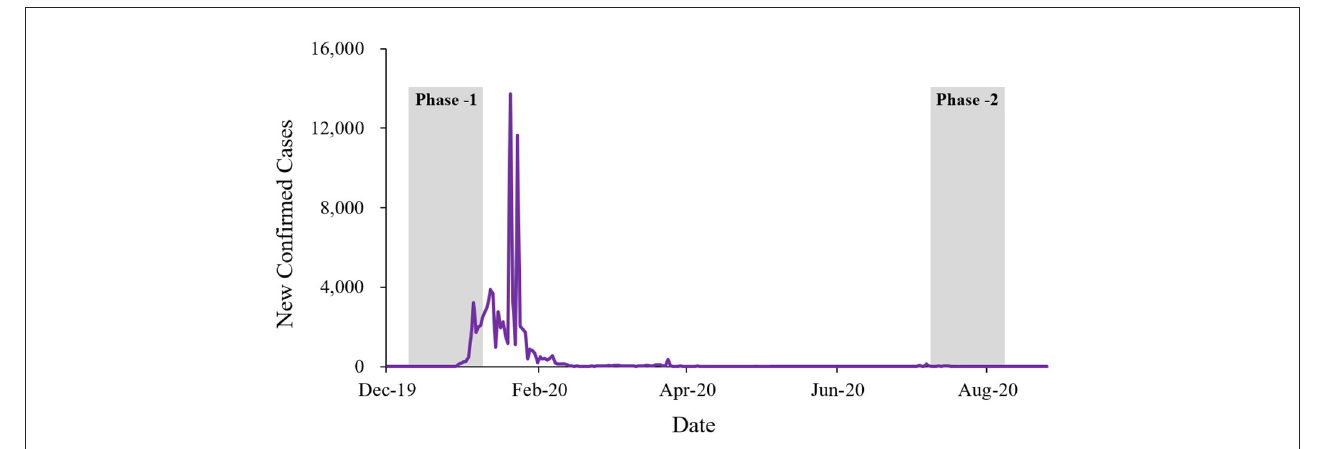
FIGURE2 The new confirmed cases of